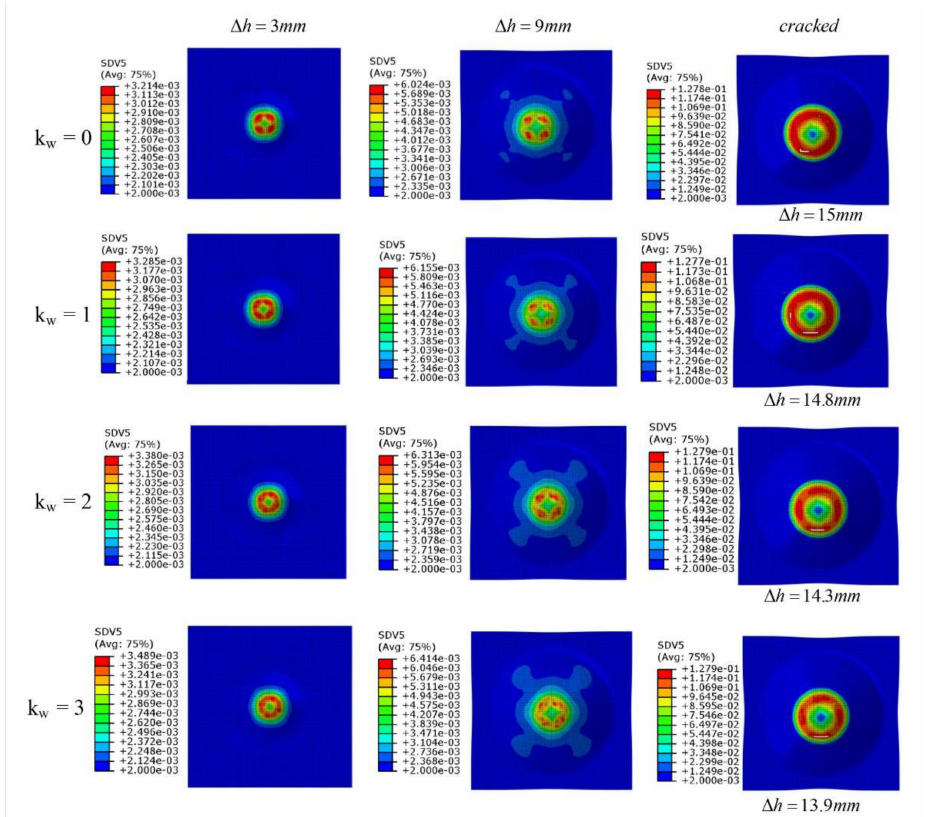
Figure 9. Damage distribution under the different displacement of the bottom die and the image of cracked sheet. (SDV5 represented void volume fraction).